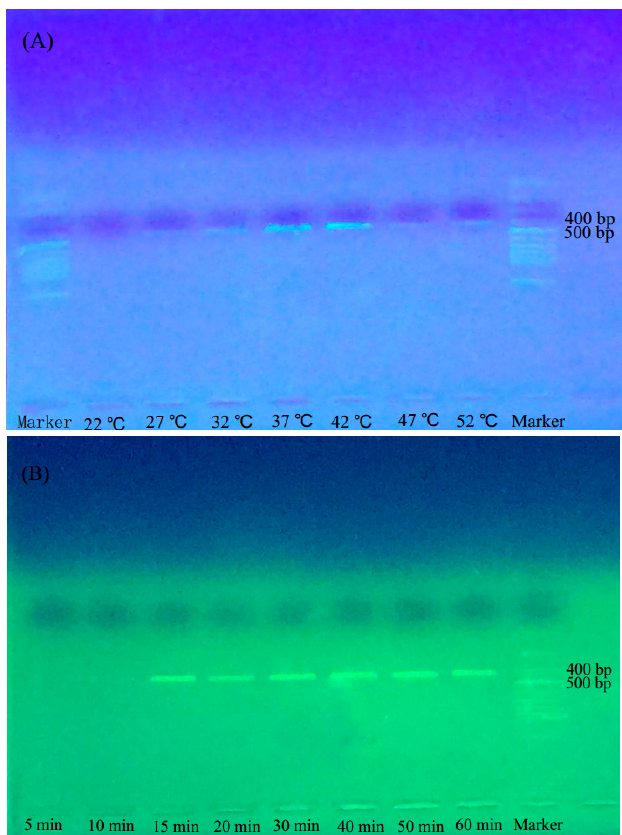
Figure 1. Results of optimal temperature ( A ) and time ( B ) for the DNA barcode-based recombinase polymerase amplification (BAR-RPA) reaction. ( A ) The optimization of temperature for the BAR-RPA (range: 22–52 °C); ( B ) The optimization of time for the BAR-RPA (range: 5–60 min). Lane Marker: 50 bp DNA ladder.